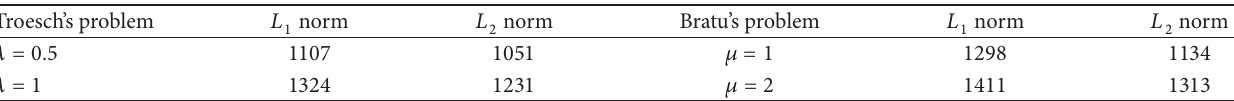
Table 11: The effect of the vector norm on the convergence speed of the algorithm for Troesch’s and Bratu’s problems. Troesch’s problem 𝐿 1 norm 𝐿 2 norm Bratu’s problem 𝐿 1 norm 𝐿 2 norm 𝜆 =